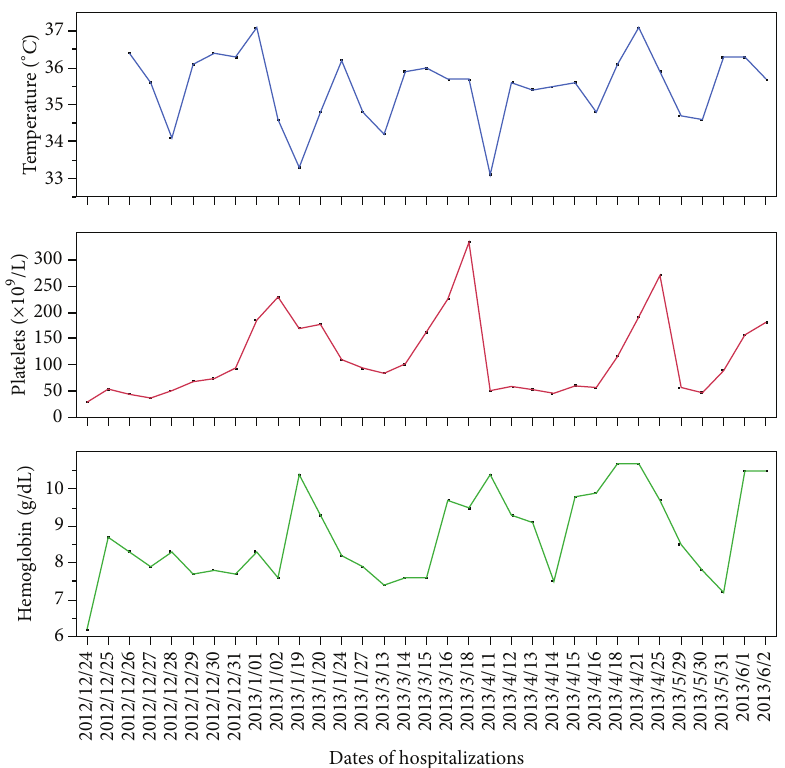
Figure 1: Variation of platelet count, hemoglobin, and body temperature as a function of time in a patient with Shapiro syndrome causing cyclic hypothermia demonstrating episodic bicytopenia with hypothermic